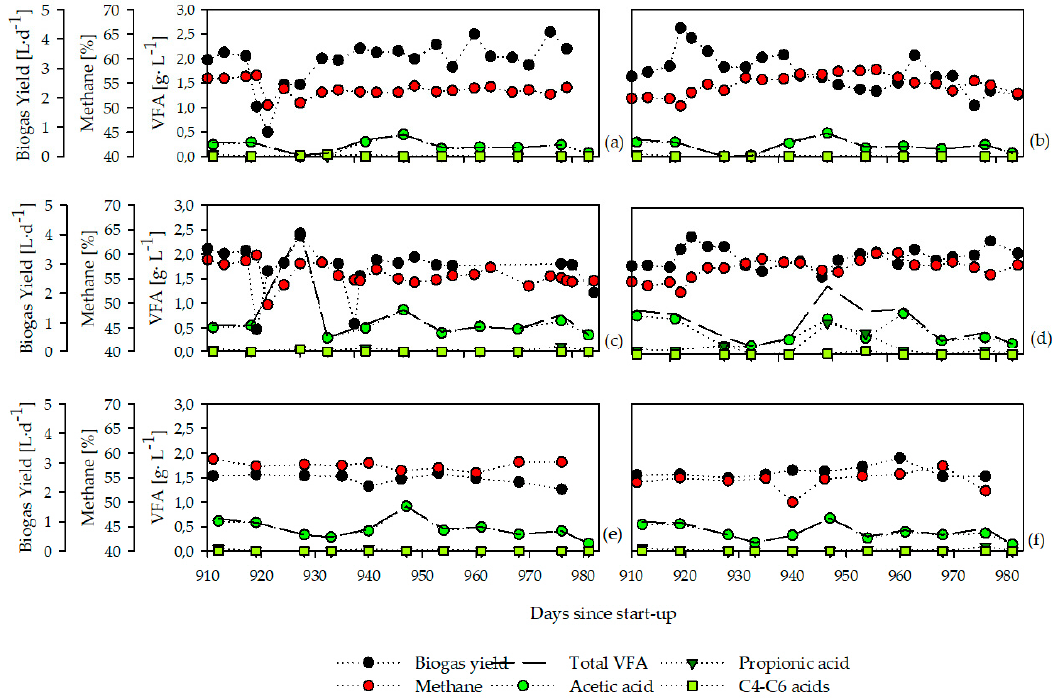
Figure 1. Biogas yields, methane contents, and volatile fatty acids (VFA) of the investigated reactor systems: reactor formerly fed with sugar beet silage now given maize silage (SB-M1) ( a ), reactor formerly fed with maize silage now given sugar beet silage (M-SB1) ( b ), reactor formerly fed with sugar beet silage and ammonium carbonate now given maize silage and ammonium carbonate (SB-M2) ( c ), reactor formerly fed with maize silage with ammonium carbonate now given sugar beet silage and ammonium carbonate (M-SB2) ( d ), reactor formerly fed with 25% sugar beet silage and 75% animal manure now given 25% maize silage with 75% animal manure (SB-M3) ( e ), and reactor formerly with 25% maize silage and 75% animal manure now given 25% sugar beet silage with 75%